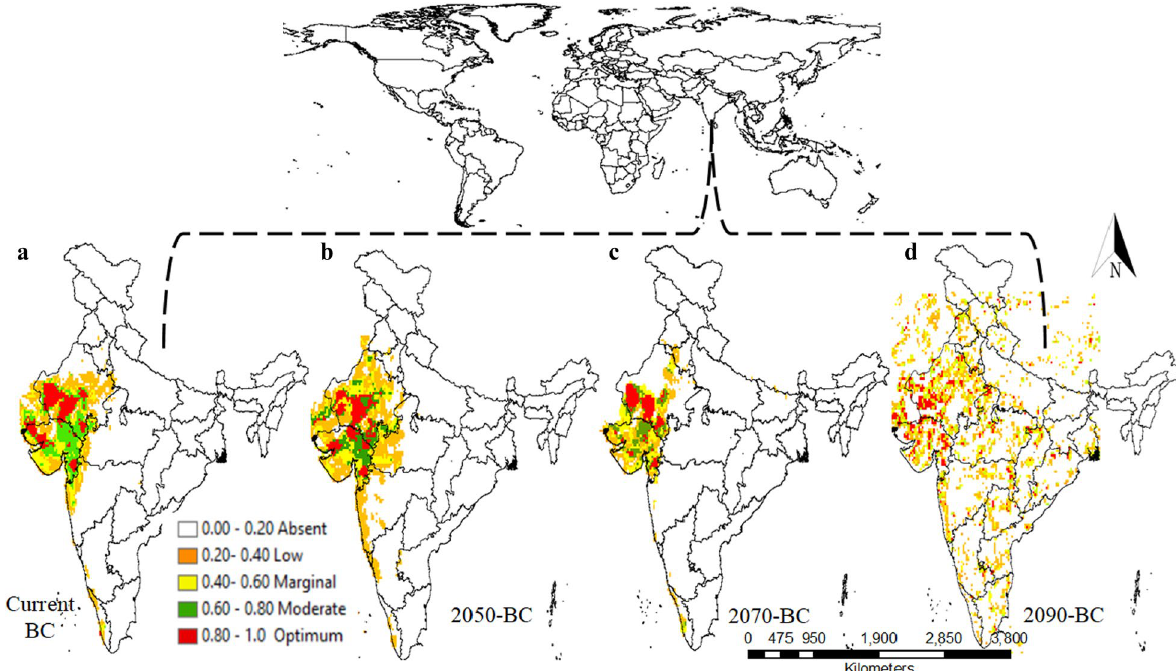
Fig. 14 Projected habitat suitability classes of C. wightii in India during various bioclimatic projection current ( a ), 2050 ( b ), 2070 ( c ) and 2090 ( d